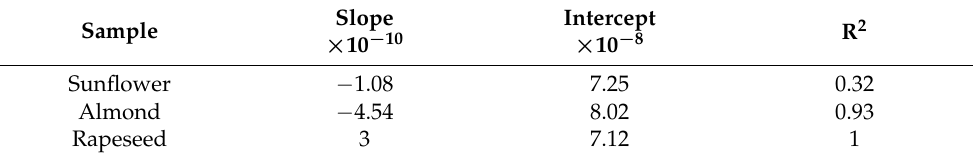
Table 1. The linear coefficient for thermal diffusivity behavior for the studied samples.